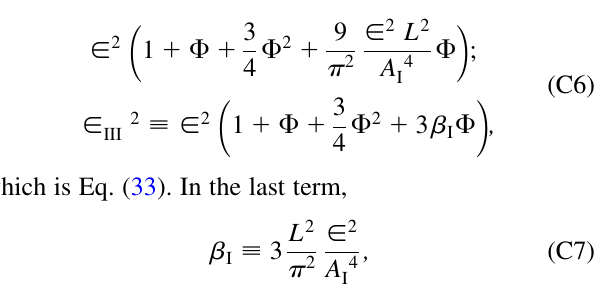
(cid:6) nh =h and c for FODO case with four n n 1 1